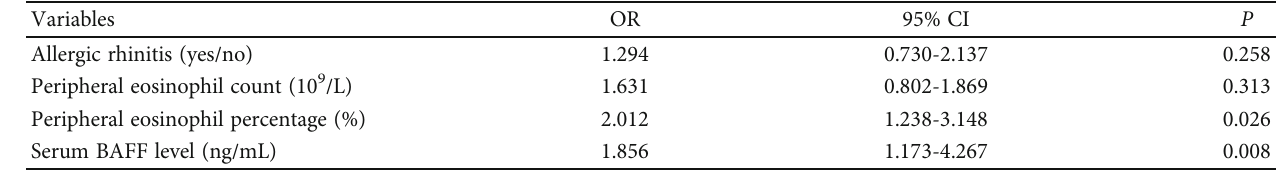
Figure 5: Histopathology and BAFF protein expression in primary and recurrent CRSwNP patients. Representative H&E images from (a) primary and (b) recurrent CRSwNP patients. (c – f) Representative IHC staining of BAFF between two groups (magni fi cation, 200x and 400x). BAFF: B cell-activating factor; H&E: hematoxylin and eosin; CRSwNP: chronic rhinosinusitis with nasal polyps; IHC: immunohistochemistry. Table 4: Multivariate analysis of factors associated with the recurrence of